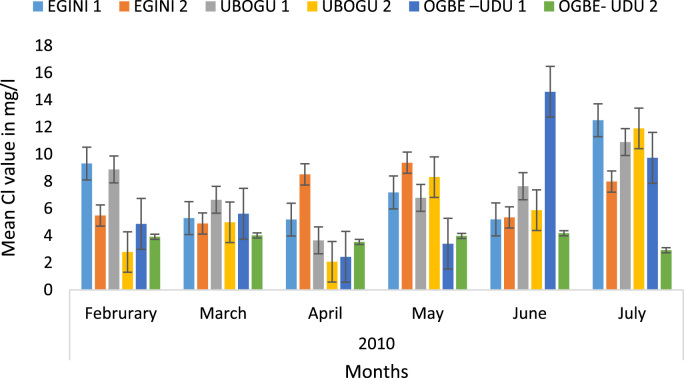
Mean Temporal and spatial variations in CI.